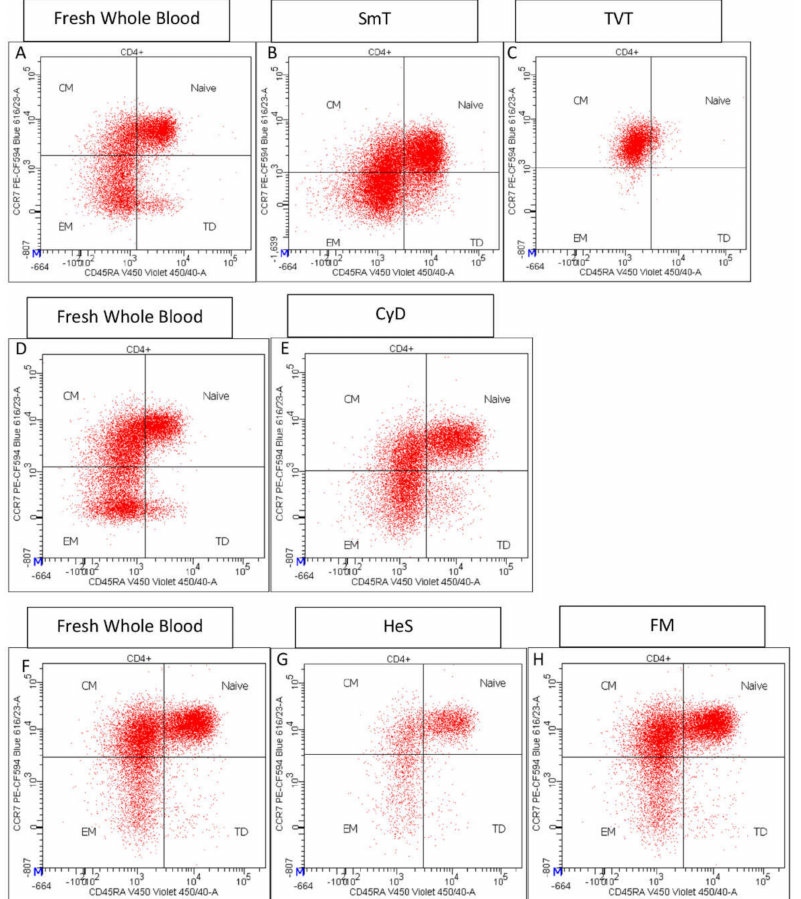
Figure 6. Representative CD45RA vs. CCR7 staining of fresh whole blood and thawed samples. The corresponding fresh whole blood is shown in the same line for each freezing method: fresh blood ( A ) is the control for SmT ( B ), and TVT ( C ) methods; fresh sample ( D ) is used as the control for CyD ( E ) method, and fresh sample ( F ) for HeS ( G ) and FM ( H )